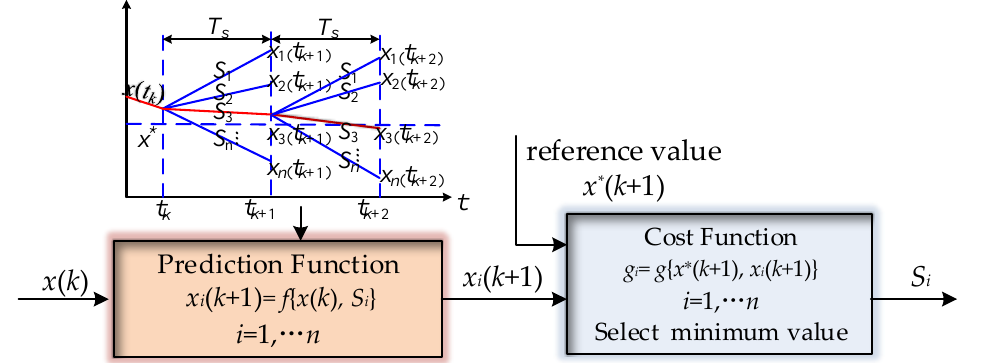
Figure 3. Model predictive control (MPC) principle.